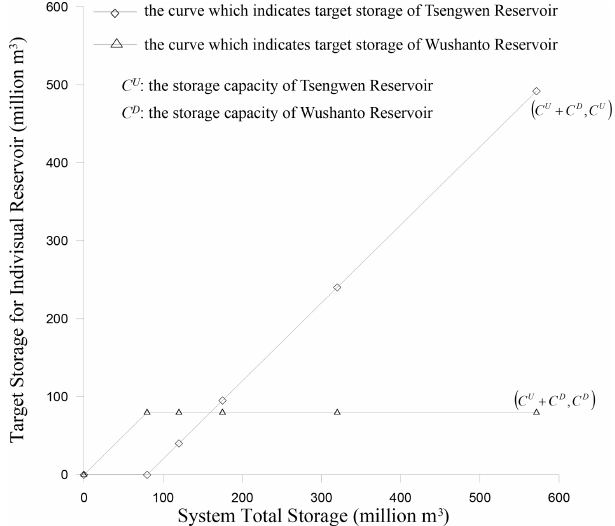
Figure 7. Modified storage balancing curves using Tsengwen Reservoir as primary source to satisfy water